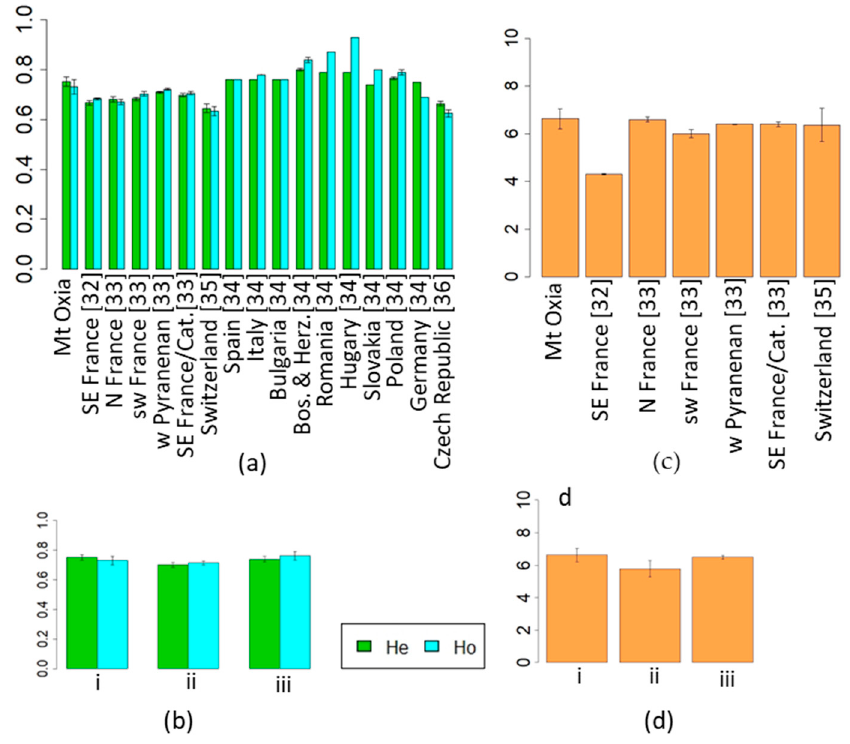
Figure 3. Comparing: ( a , b ) Observed and Expected Heterozygosity and ( c , d ) Allelic Richness of Mt. Oxia with populations from SW and the main region of Fagus sylvatica distribution. i: Mt Oxia, ii: SW Part [32–34], iii: Main range [33–36]. Numbers in brackets are the references used. Cat.: Catalonia, Bos.: Bosnia; Herz.: Herzegovina.